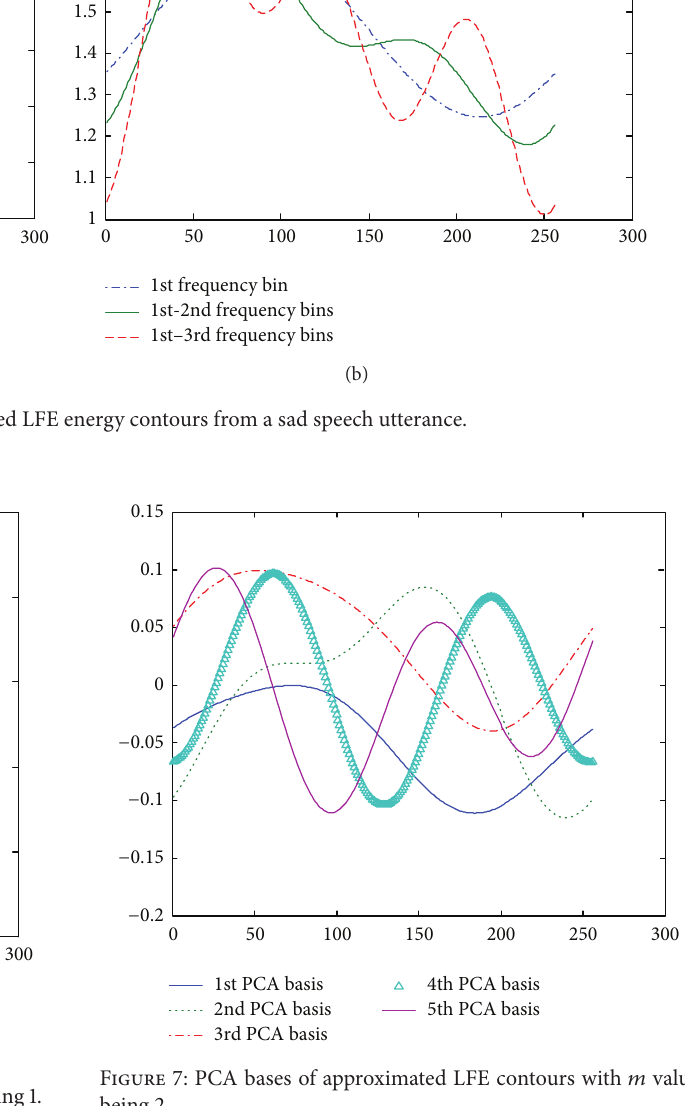
𝑚 value being 1, 2, and 3, respectively. It is noted that only significant PCA bases are shown in these figures.